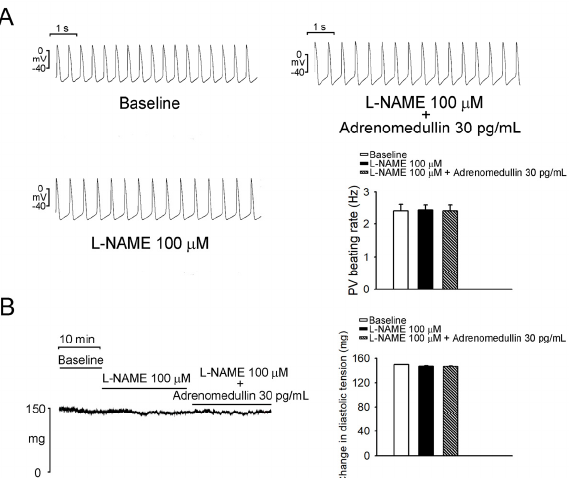
Figure 3. Interactions of L-NAME and adrenomedullin on PV electrical activity. ( A ) Adrenomedullin at 30 pg/mL did not reduce PV beating rates in the presence of 100 µ mol/L L-NAME. ( B ) Adrenomedullin at 30 pg/mL did not reduce PV diastolic tension in the presence of 100 µ mol/L L-NAME. 2.2. Effects of Adrenomedullin on Left Atrium (LA) and Right Atrium (RA) Electrophysical Characteristics and Contractility Adrenomedullin at 30 and 100 pg/mL (but not 10 pg/mL) reduced LA action poten- tials duration (APD) 50 (Figure 4), and adrenomedullin at 100 pg/mL reduced LA APD 20 . However, adrenomedullin (10, 30, or 100 pg/mL) did not alter LA resting membrane po- tential (RMP) or APD 90 . Adrenomedullin at 100 pg/mL reduced RA APD 20 and APD 50 (Fig- ure 5), but adrenomedullin (10, 30 pg/mL) did not alter the action potentials amplitude (APA), RMP, or APD 90 of the RA. Finally, adrenomedullin did not reduce the contractility of the LA or RA (Figures 4 and 5).